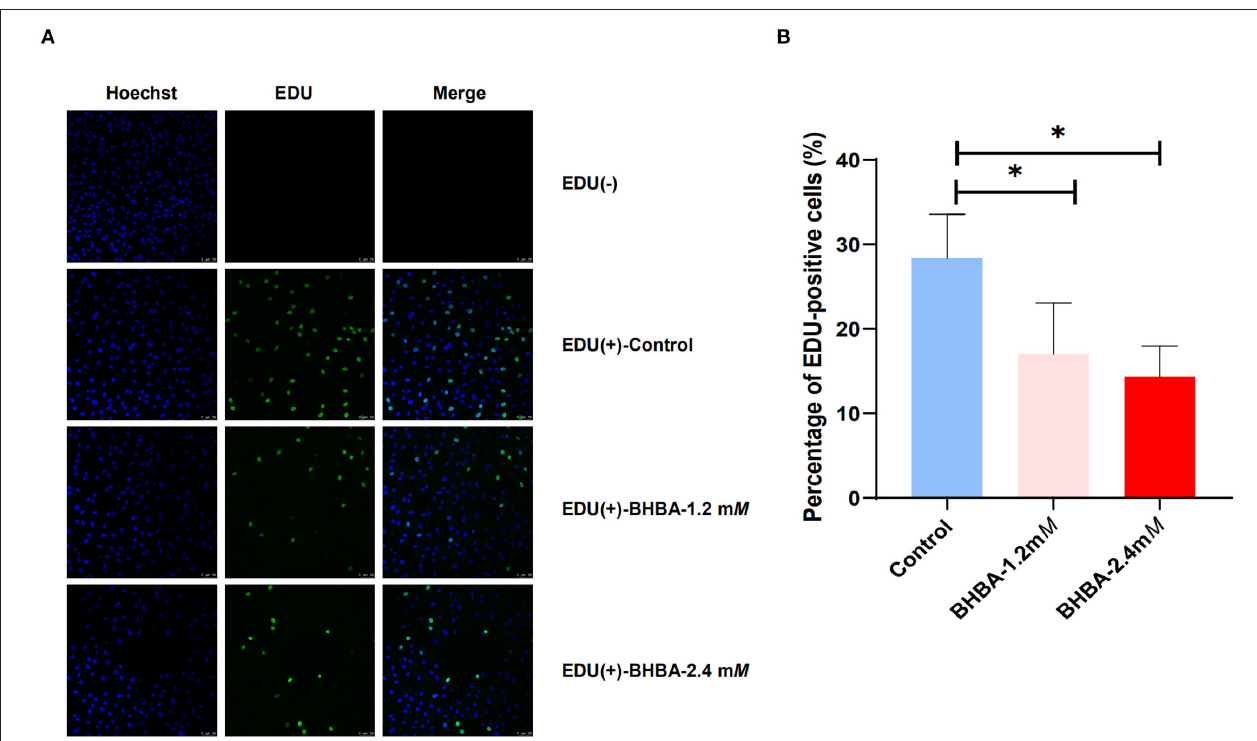
FIGURE 1 | The effect of different concentrations of BHBA stimulation on the proliferation rate of GCs. (A) The proliferation of GCs was detected by EdU. Cell nuclei were stained blue by Hoechst 33342. (B) EdU-positive cells (shown in green) were counted and the percentage was calculated. The bar graph shows the mean ± SD of each group, * P <